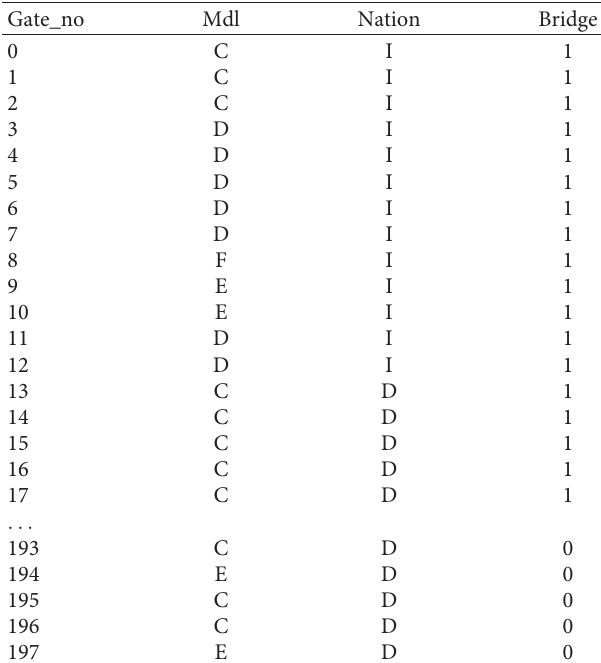
Table 5: Basic information of airport